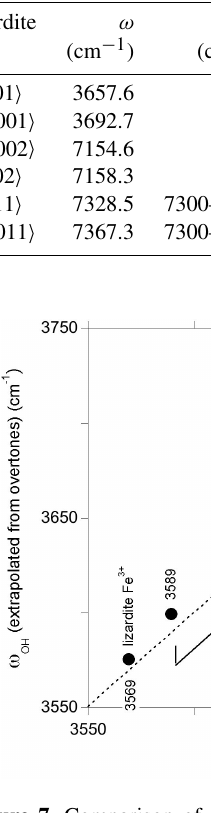
Figure 7. Comparison of fundamental frequencies with frequen- cies extrapolated from overtone bands using the 1-D approximation (Eq. 1). The squares and circles correspond to inner and interlayer OH groups, respectively. The 3642 and 3653cm − 1 frequencies cor- respond to Raman data (Campagnoni et al., 2021) and are not re- solved in the MIR spectrum of lizardite (Fig. 1). The interlayer OH frequencies of brucite and lizardite are those inferred for the uncou- pled OH oscillator (see